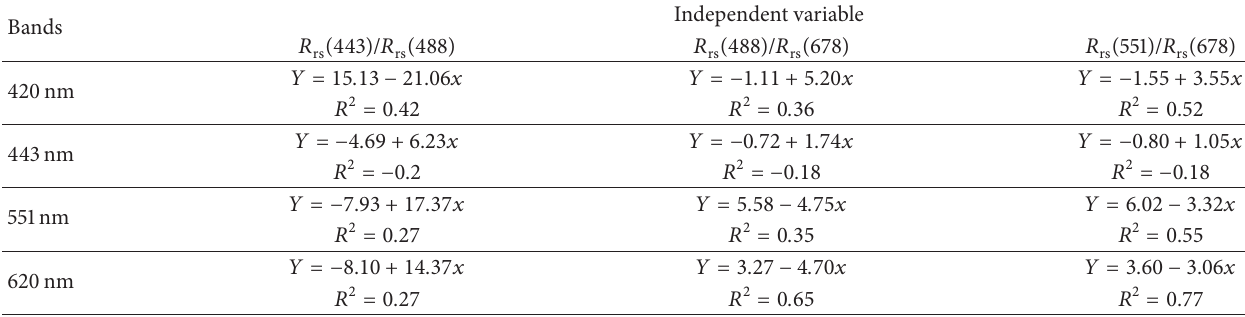
Table 2: Simulated results of double-band